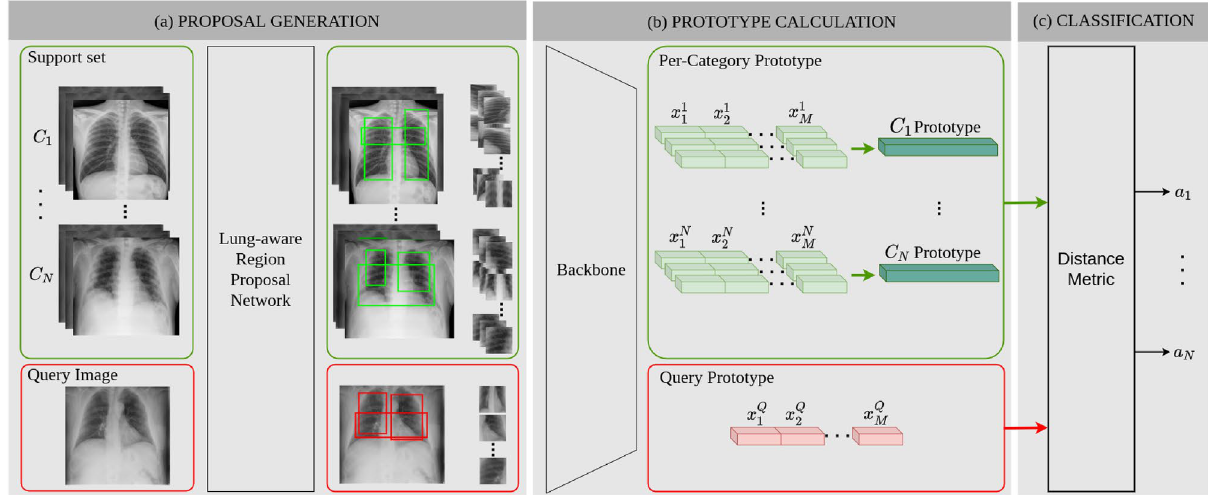
Figure 1. Image classification pipeline for one support set. First, a proposal generator calculates M regions of interest from the images in the support set and the query image, respectively. Then, per-region deep feature maps x i are calculated for both the support set and query images. These per-region feature maps are concatenated, resulting in a per-image feature map. Support feature maps for every image in each category C i are aggregated calculating a per category prototype. Finally, the query image feature map (query prototype) is compared with per category support feature maps to obtain the affinity vectors a i